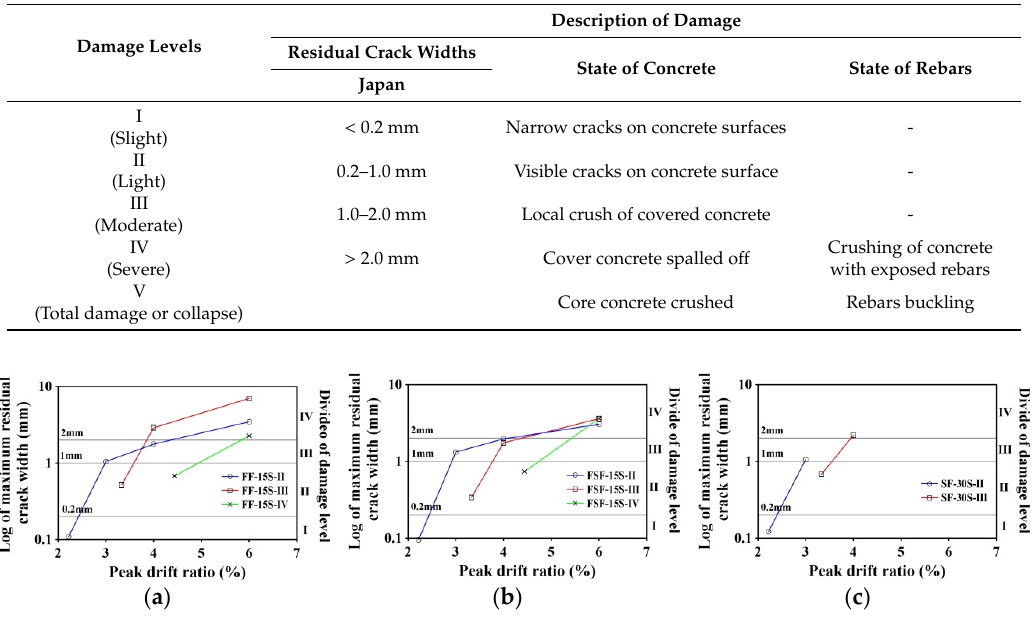
Figure 10. Maximum residual crack widths for each specimen. ( a ) FF-15S; ( b ) FSF-15S; ( c ) SF-30S